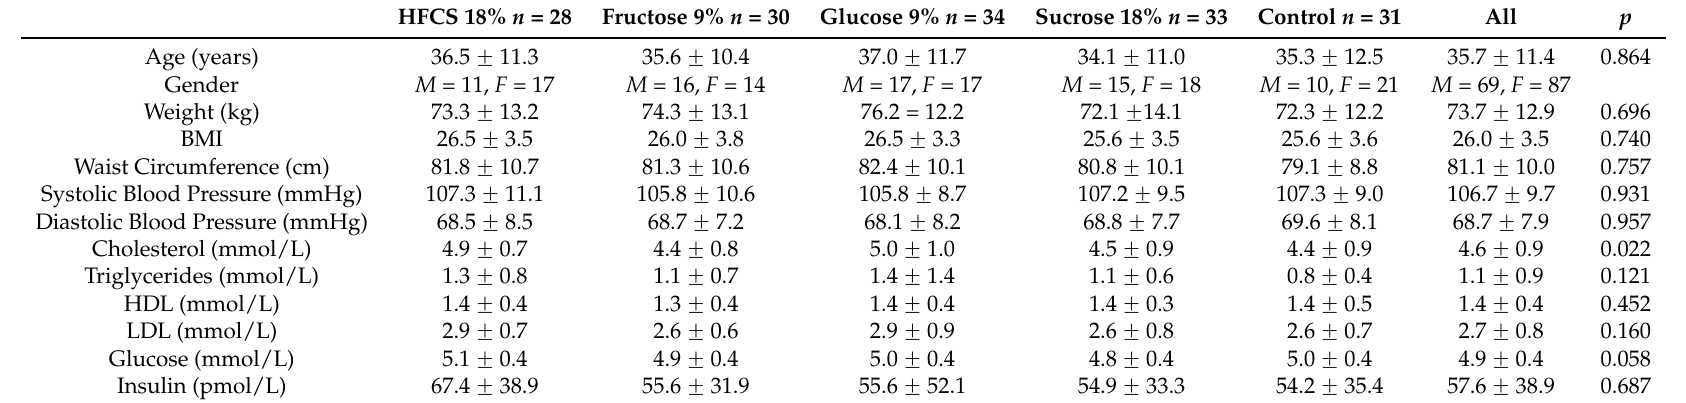
Table 2. Baseline characteristics of the 156 participants who completed the